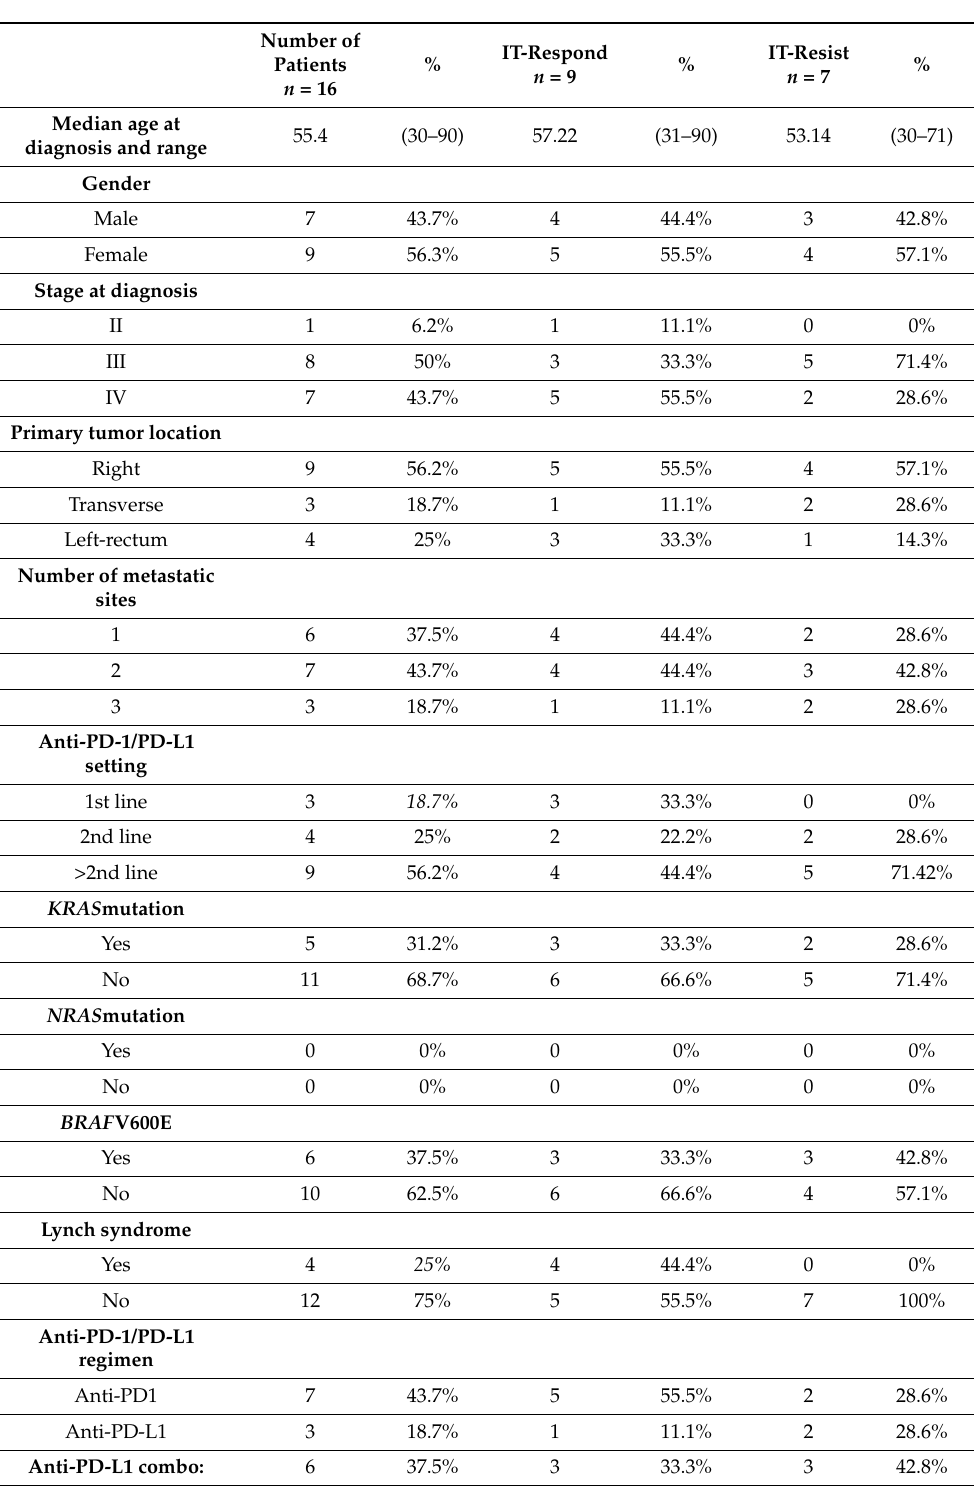
Table 1. Cohort description. Characteristics are specified for the overall population and for each group (IT-responder and IT-resistant). Anti-PD-1/PD-L1 response is defined according to RECIST v1.1. The percentage of patients diagnosed with Lynch syndrome in a genetic counselling unit and/or receiving anti-PD-1/PD-L1 in 1st line setting are in italics since they are all clustered in IT-responder. Mutations in KRAS and BRAF V600E determined by standard practice were similarly distributed between the groups. CR: complete response. PD: progression disease. PR: partial response. SD: stable